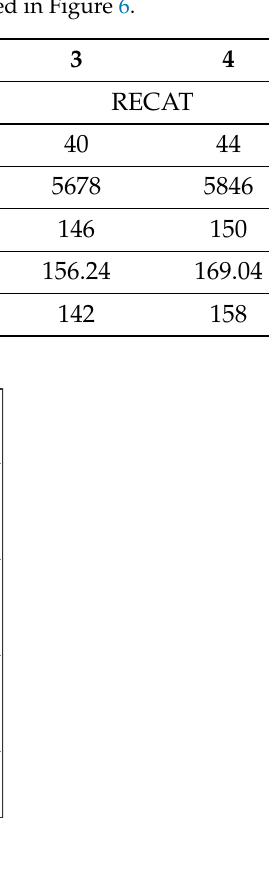
Figure 15. Comparison of vectoring delay per aircraft on